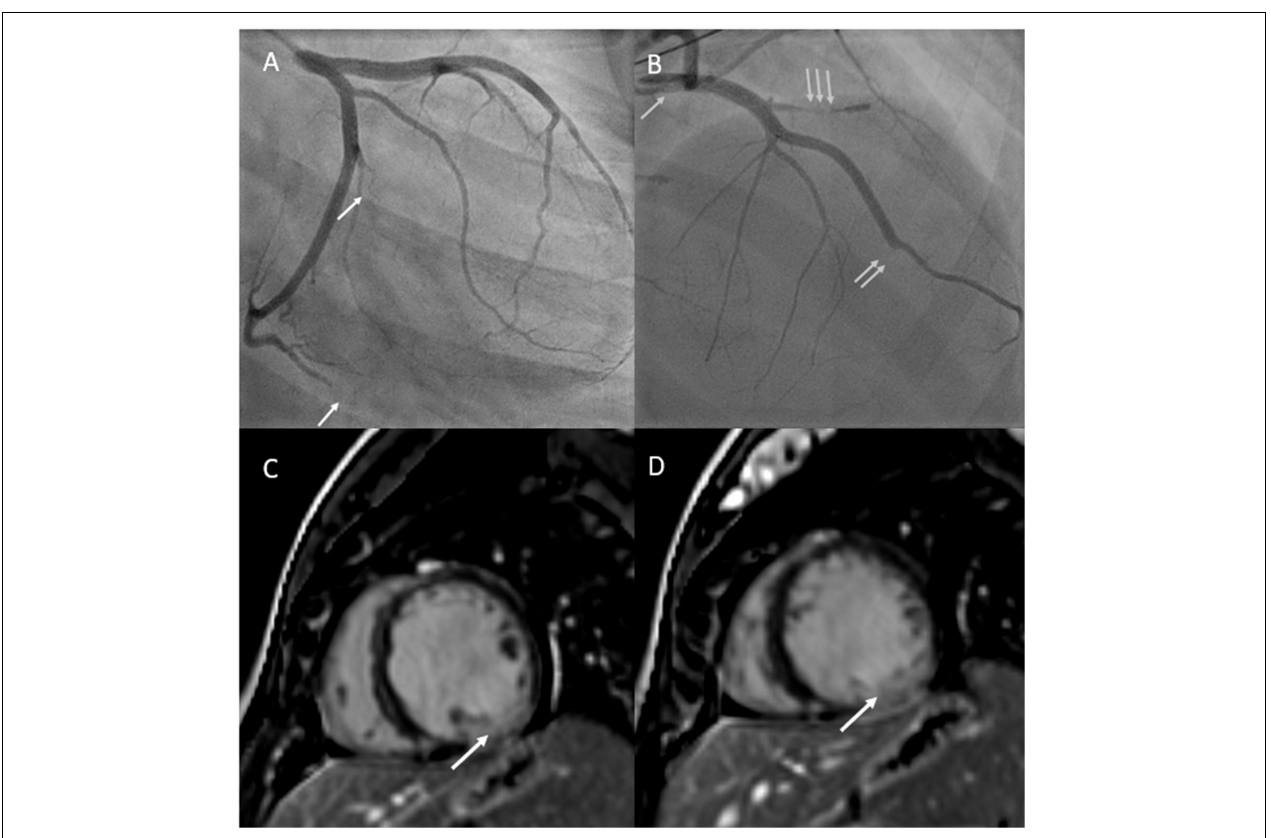
FIGURE 2 | (A) Depicts cardiac angiogram demonstrating occluded cardiac marginal arteries (arrows). (B) Depicts cardiac angiogram demonstrating dissected left main coronary artery (single arrow), occluded left anterior descending artery (double arrow), and occluded diagonal artery from the left anterior descending artery (triple arrow). (C,D) Reveal cardiac MRI with gadolinium enhancement with phase sensitive inversion recovery showing basal to mid transmural late gadolinium enhancement in the inferior and inferolateral walls (left circumflex artery territory) secondary to spontaneous coronary artery